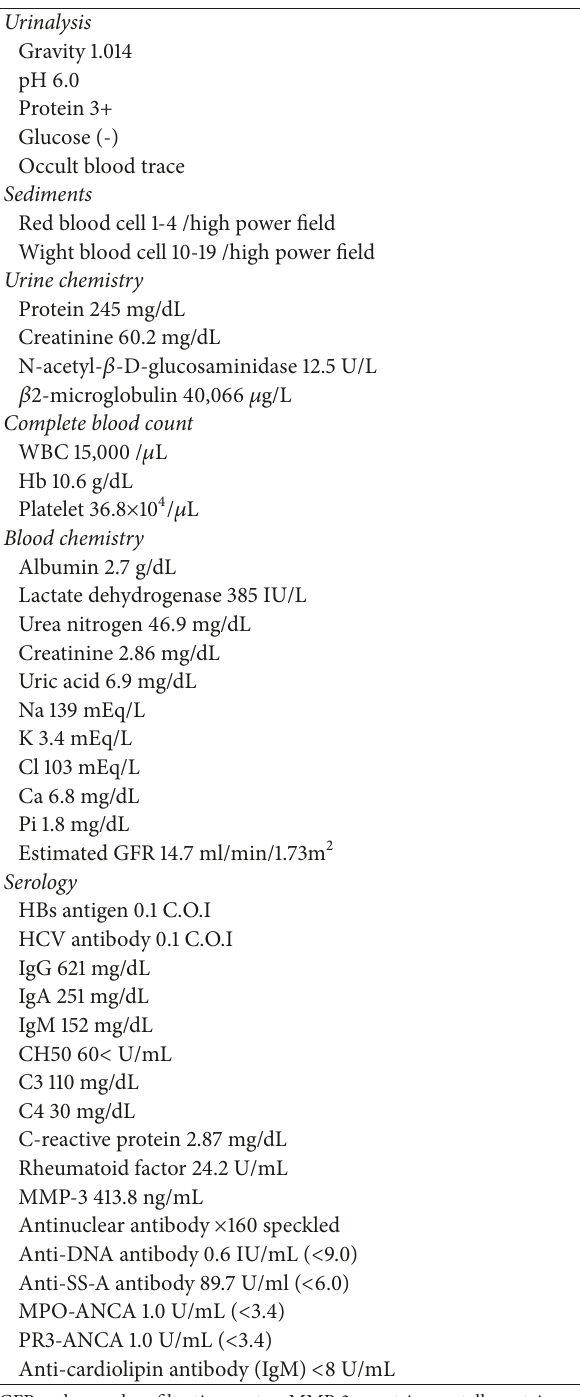
Table 1: Laboratory data on